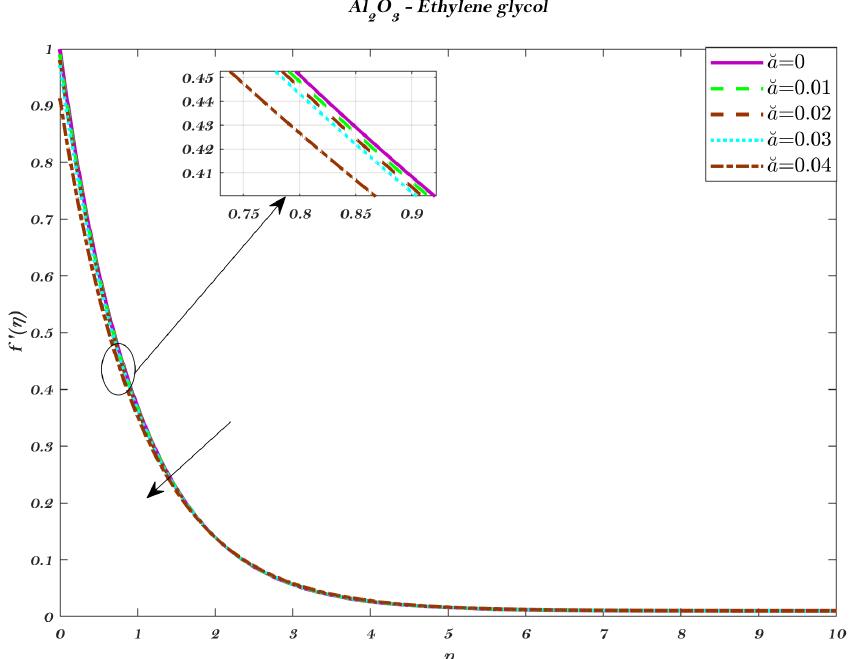
Figure 9. The influence of the slip parameter ˘ a against η on the velocity profile with ϕ = 3%, (cid:101) = 0.01 and R =